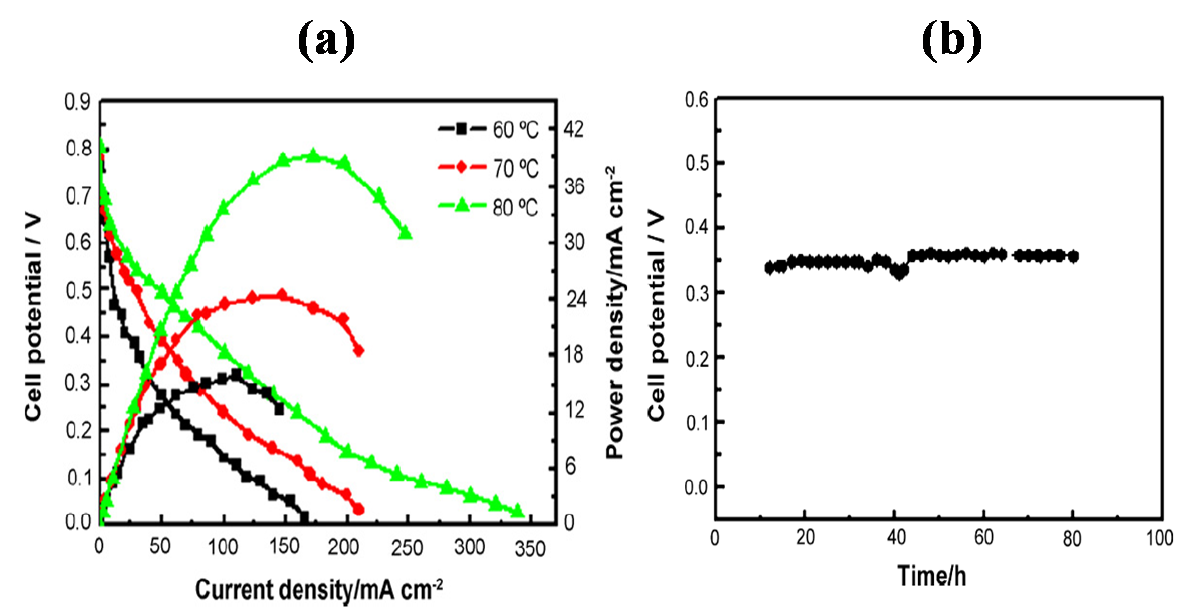
Figure 14. (a) Polarization curves at different cell temperatures of the single cell with the W N/C as the cathode catalyst. (b) Stability test at the constant current density (Reprinted 2 from Reference 112 with permission).